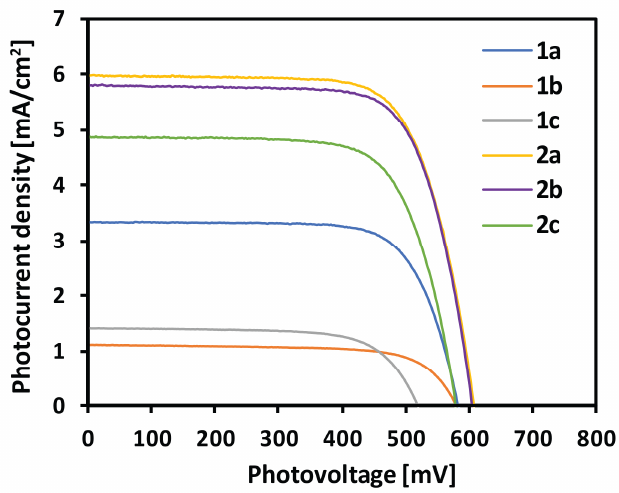
Figure 6. J–V characteristics of the fabricated solar cells.